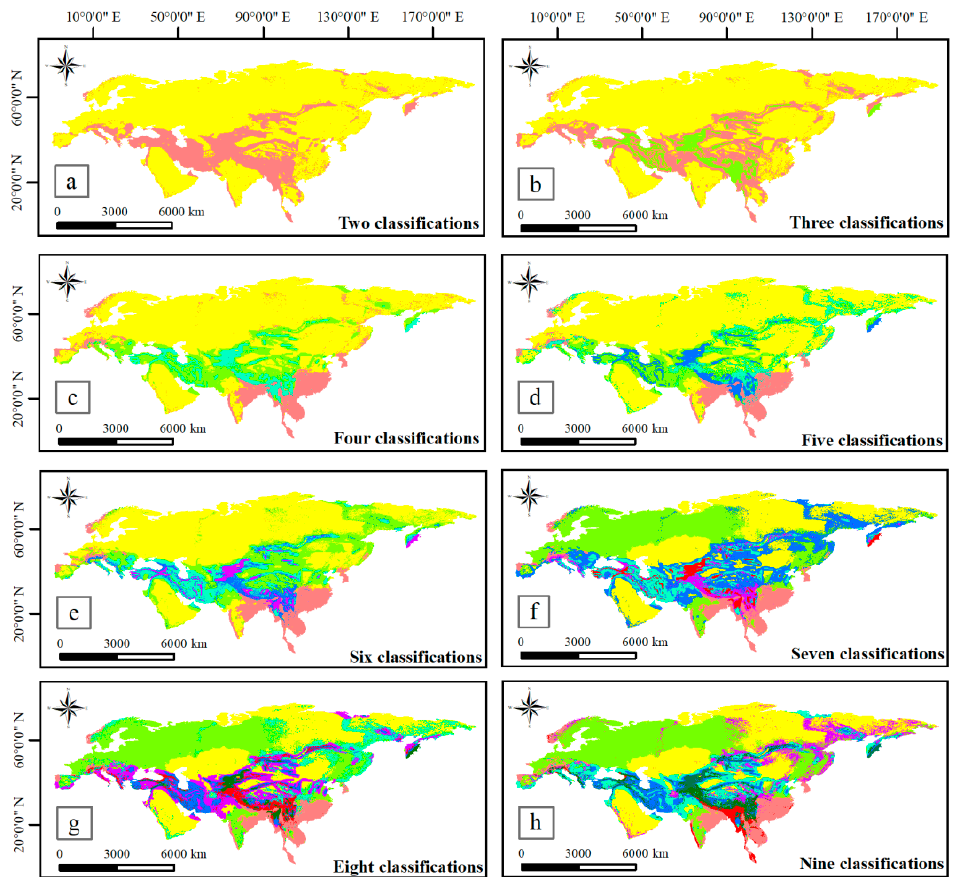
Figure 5. Unsupervised automatic classification results of the PPR data using the ISODATA method.